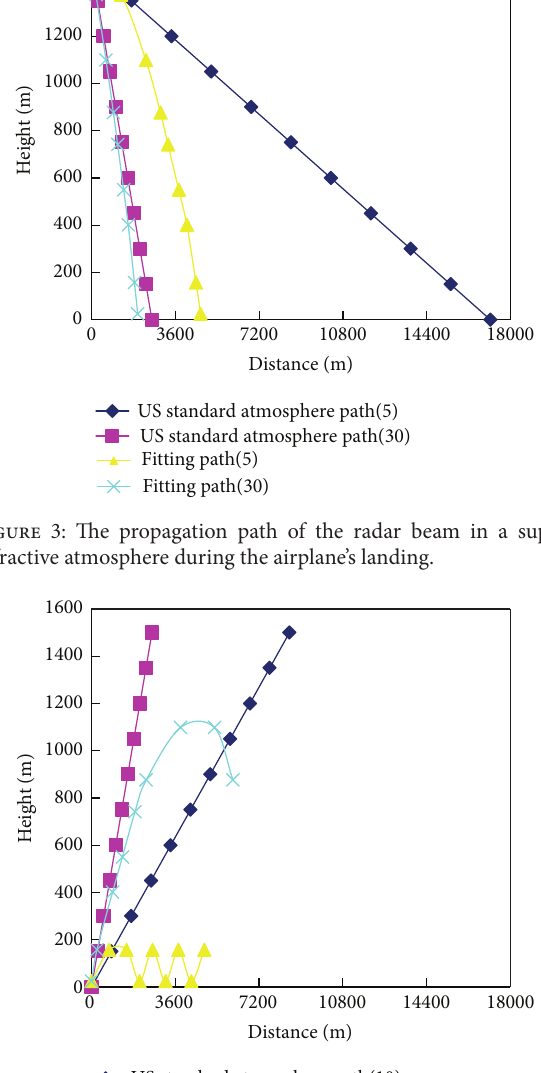
Figure 2: Change rate of the linear fit of the refraction index ( 𝑁 ) under (C) conditions.